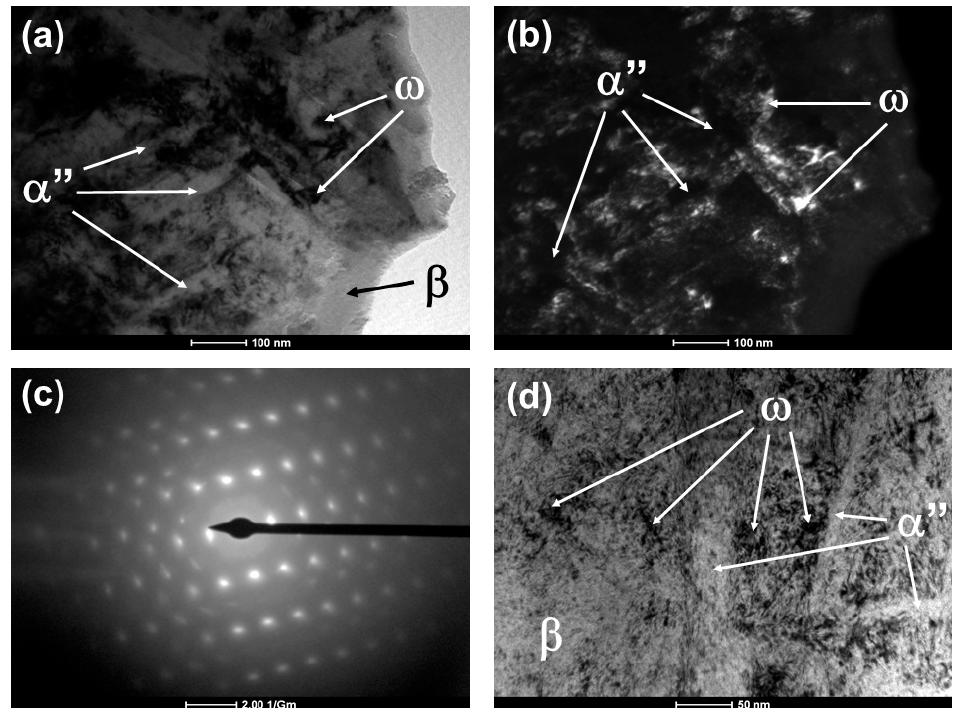
Figure 5. TEM images for Ti-25Ta-30Zr alloy after annealing with rapid cooling: bright-field ( a ), dark-field ( b ), diffraction of the selected area ( c ) and high-resolution image ( d ).